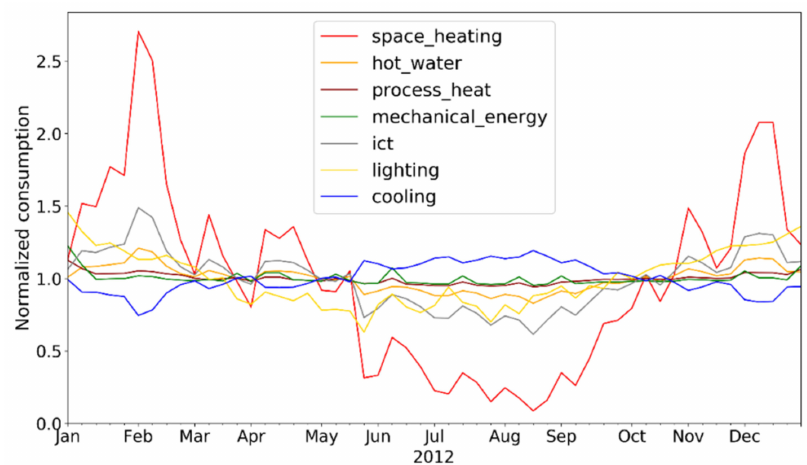
Figure 4. Seasonality of weekly mean between end-uses in the United Kingdom for the weather year 2012. A general yearly trend exists for each end-use, but deviations from that trend such as in late January and early February exist as a result of extreme weather conditions.